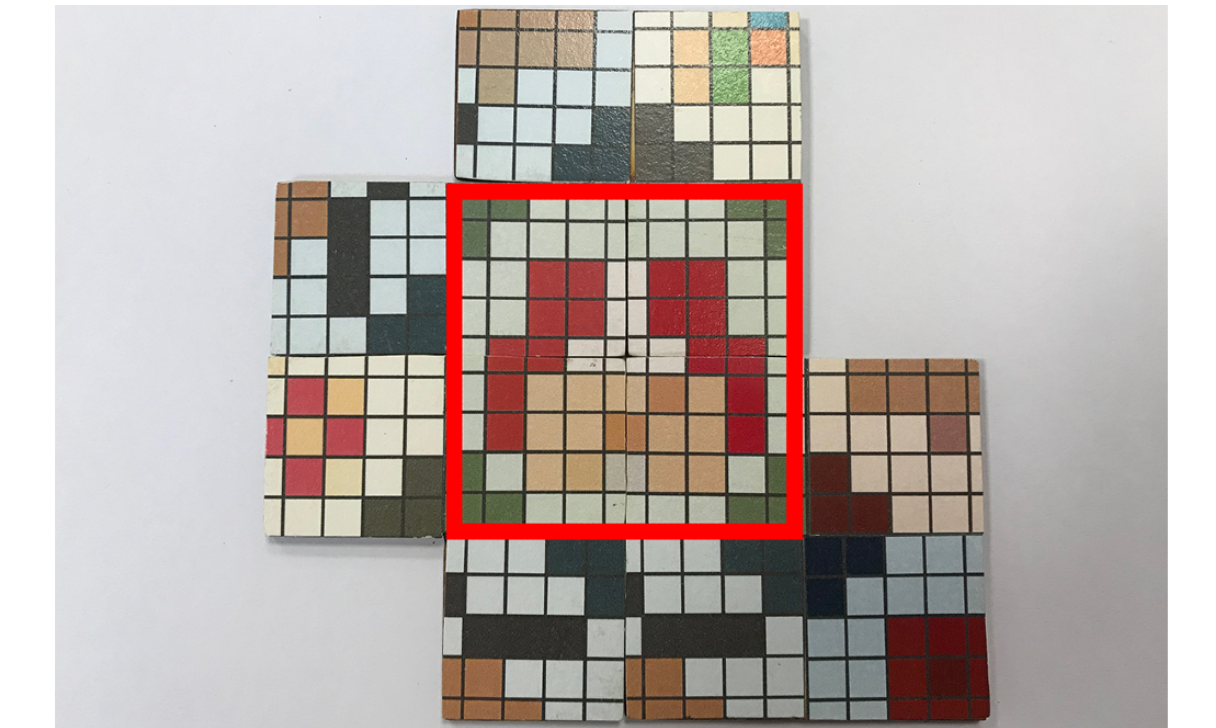
Figure 3. The red square area shows a complete pattern that was constructed using different types of puzzle